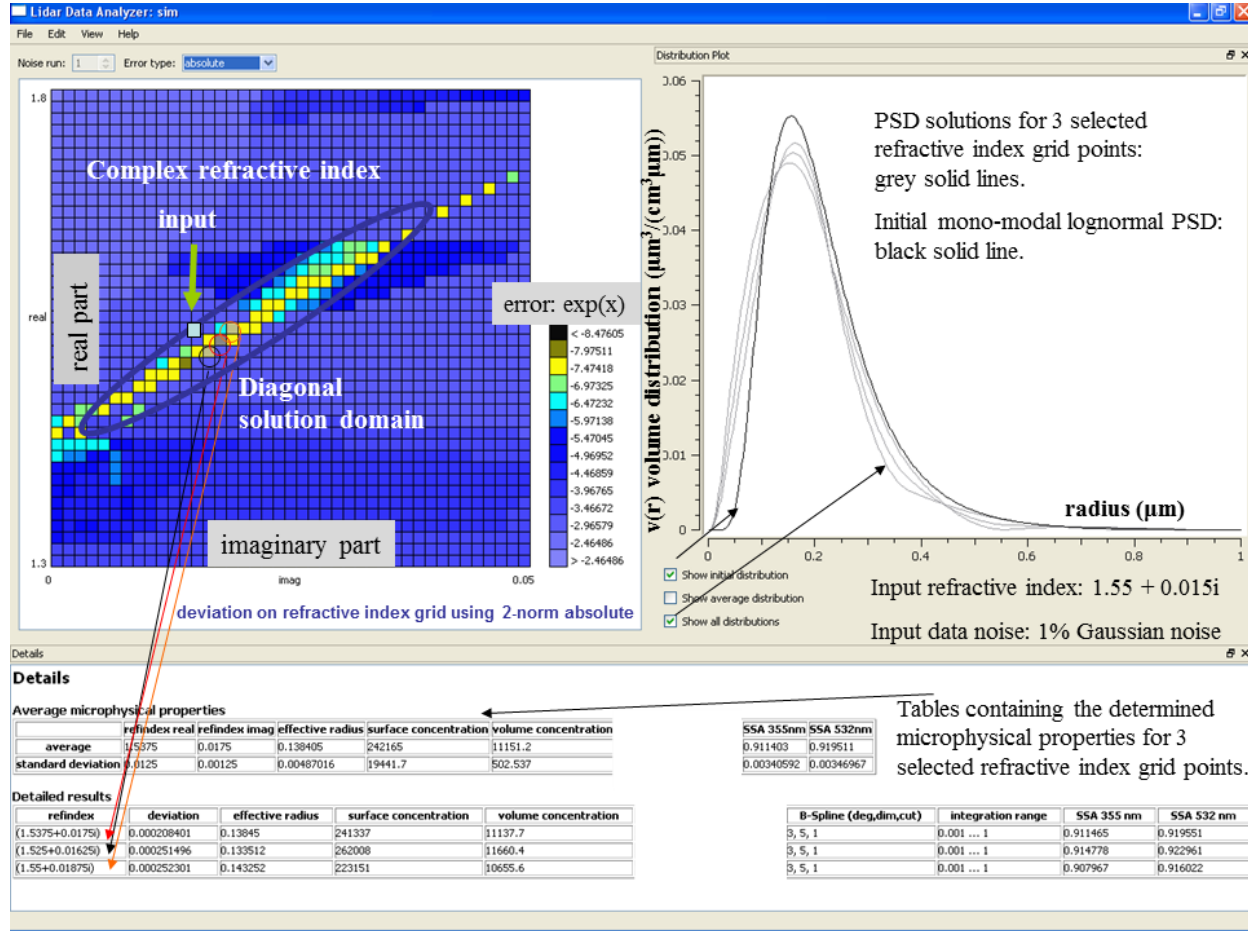
Figure 1. Screen shot of the developed software and explanation of the post-processing procedure: selection of suitable grid points of CRI clustering along the diagonal domain (left), corresponding PSD and initial PDS (right), and tables with retrieved microphysical parameters for each selected CRI and mean values with standard deviation (bottom). The residual errors on the right hand side of the grid appear in ascending order from top to bottom on a logarithmic